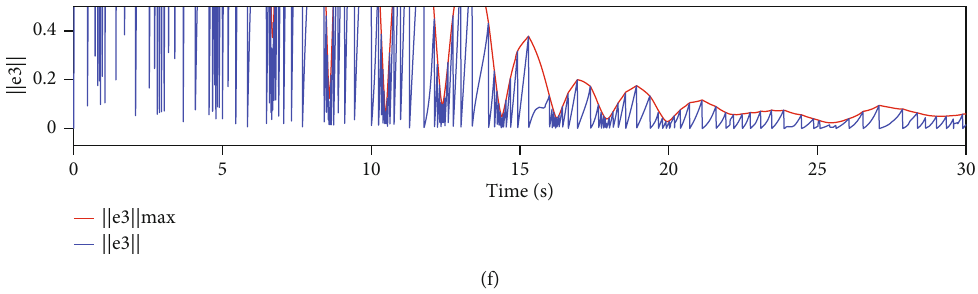
Figure 7: Variation trend of measurement error norm k e